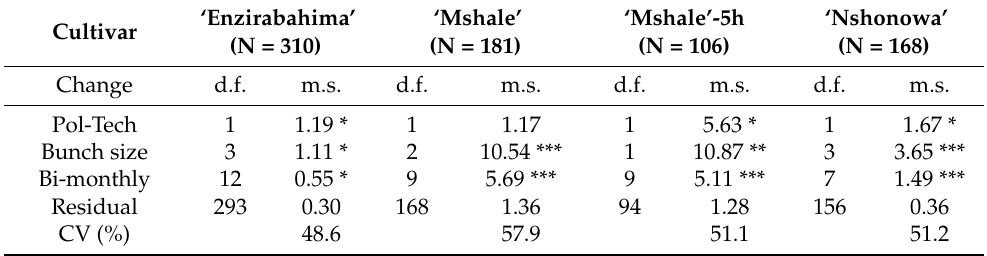
Table 2. Analysis of variance with mean squares of 3 African Highland Cooking Bananas after pollination with and without pollen germination media. Cultivar